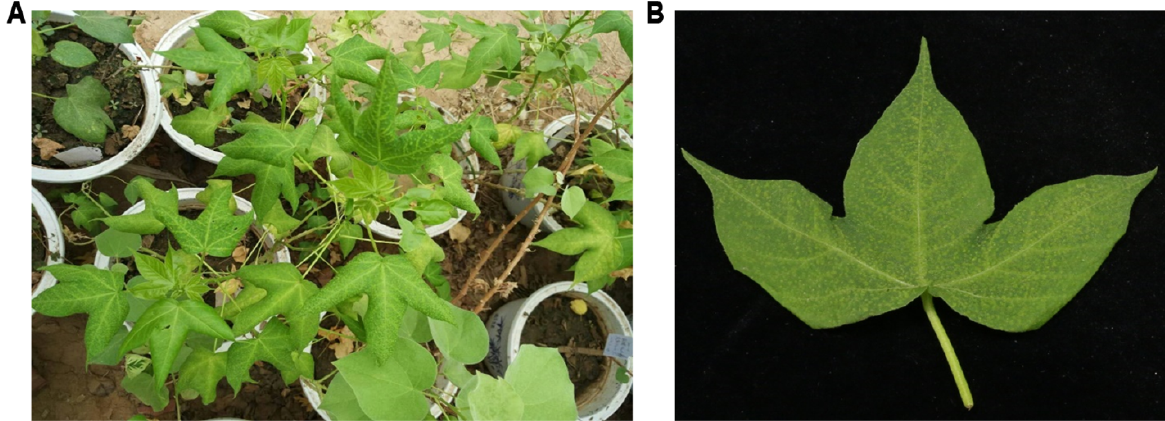
Figure 1. Symptoms on virus-infected cotton plants collected from the Henan province of China. ( A ) Symptoms on whole cotton plants. ( B ) A close view of the symptoms of diseased cotton leaf.